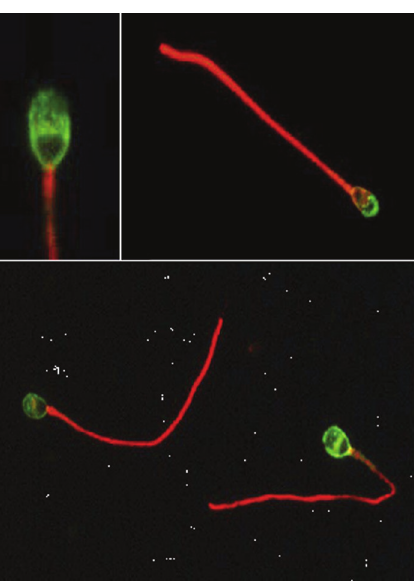
Figure 2: E ff ect of spermicidal dermaseptins on sperm acrosome and flagellar plasma membrane integrity. Motile sperm were preincubated in the presence of spermicide solution (EC100 = 25 μ g/mL) of K4S4 and was double labelled with Fluorescein Isothiocyanate-conjugated-Pisum sativum Agglutinin for acrosome labelling (FITC/green) and mouse antitubulin antibody for the flagellum staining (CY3/red). The sperm heads exhibited a “dotted” green fluorescence attesting for the presence of an acrosome. At the flagellar level, we observed a loss of membrane integrity since the anti tubulin antibodies have reached their axonemal microtubule target